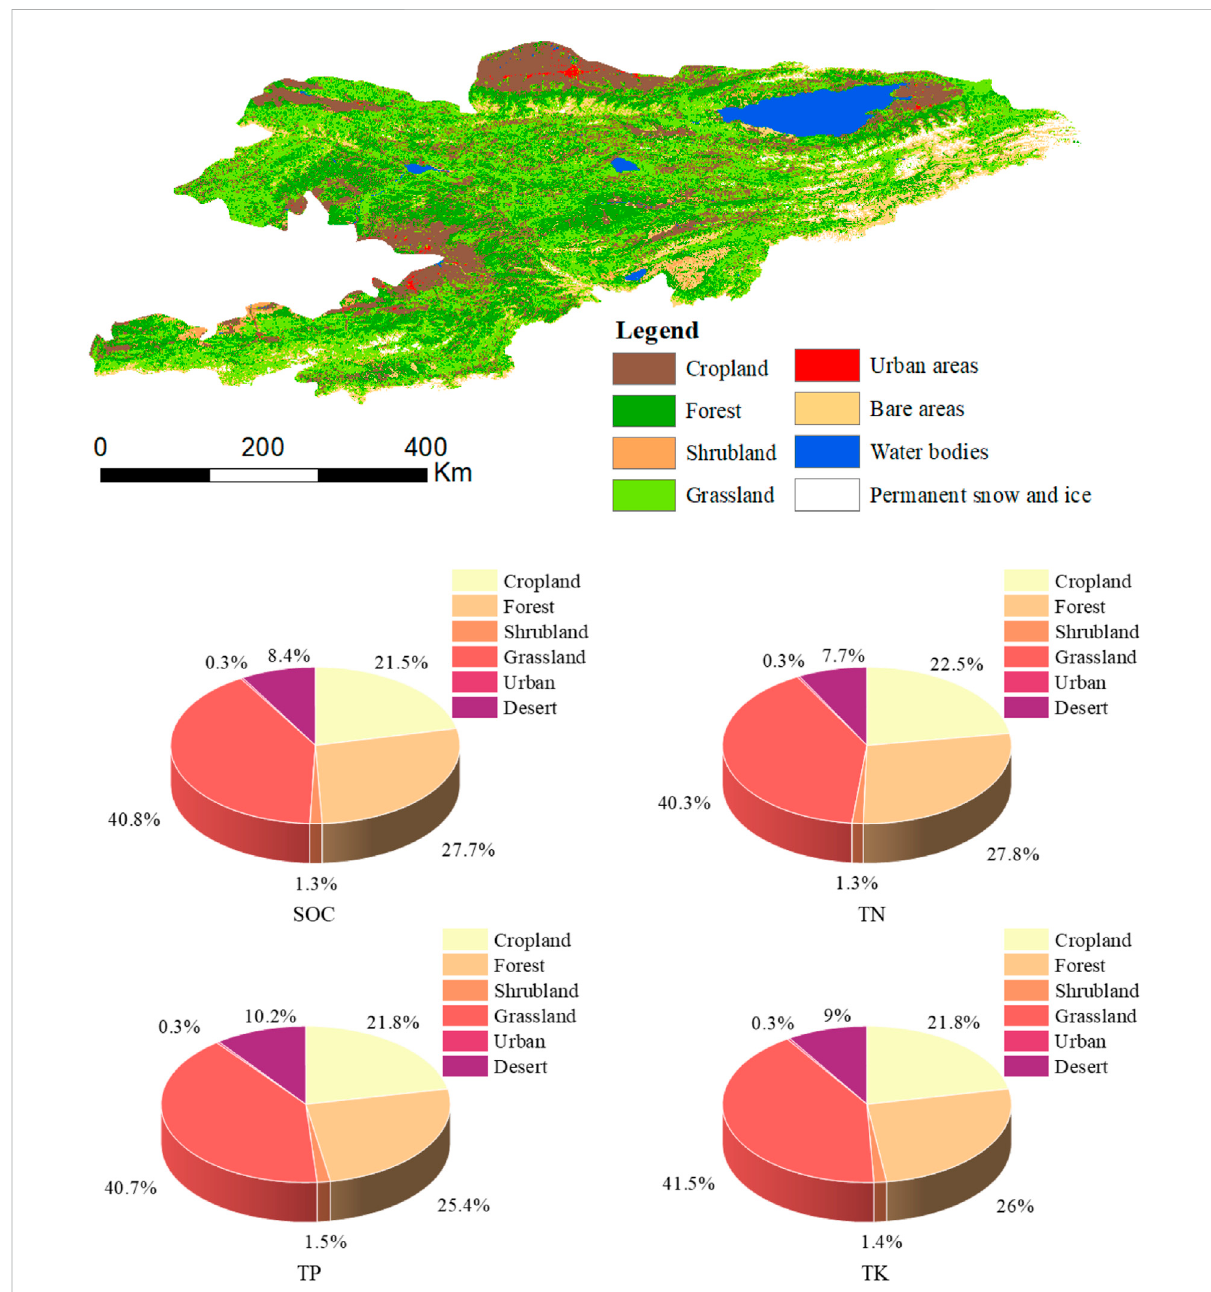
FIGURE 4 Maps of various land-cover types and proportions of nutrient stocks in each land-cover type in